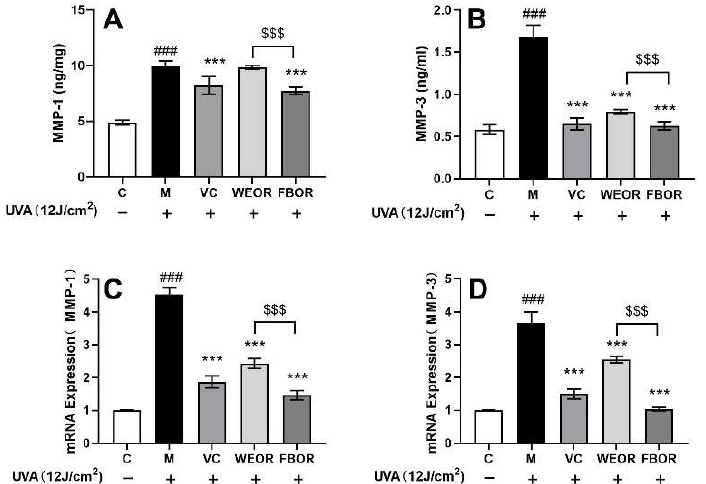
Figure 6. Effects of WEOR and FBOR on the activity and expression of MMPs in fibroblasts: ( A ) MMP-1 protein content; ( B ) MMP-3 protein content; ( C ) MMP-1 mRNA expression level; ( D ) MMP-3 mRNA expression level. (*** p < 0.001, versus the UVB irradiation model group; ### p < 0.001, versus the control group. $$$ p < 0.001, the WEOR group versus the FBOR group. C: Control group; M: UVB irradiation model group).